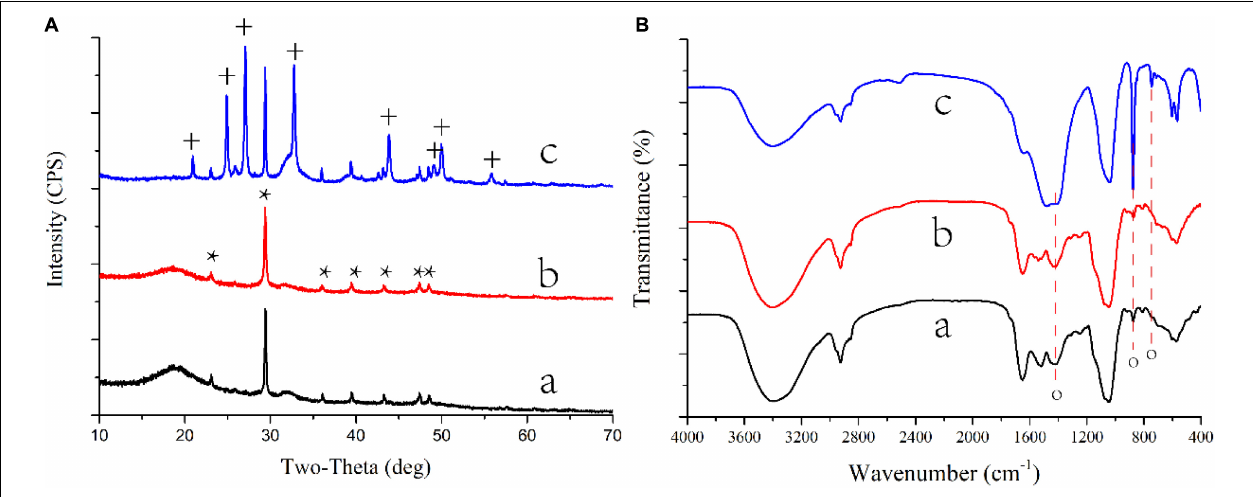
FIGURE 2 | XRD patterns (A) and FTIR spectra (B) of CaCO 3 on biomass synthesized by S. cerevisiae in different conditions. a, acetate in B4 medium; b, lactate in B4 medium; c, acetate in B4 medium without glucose; *, the base peak of calcite; +, the peak of vaterite. o, the base peak of calcium